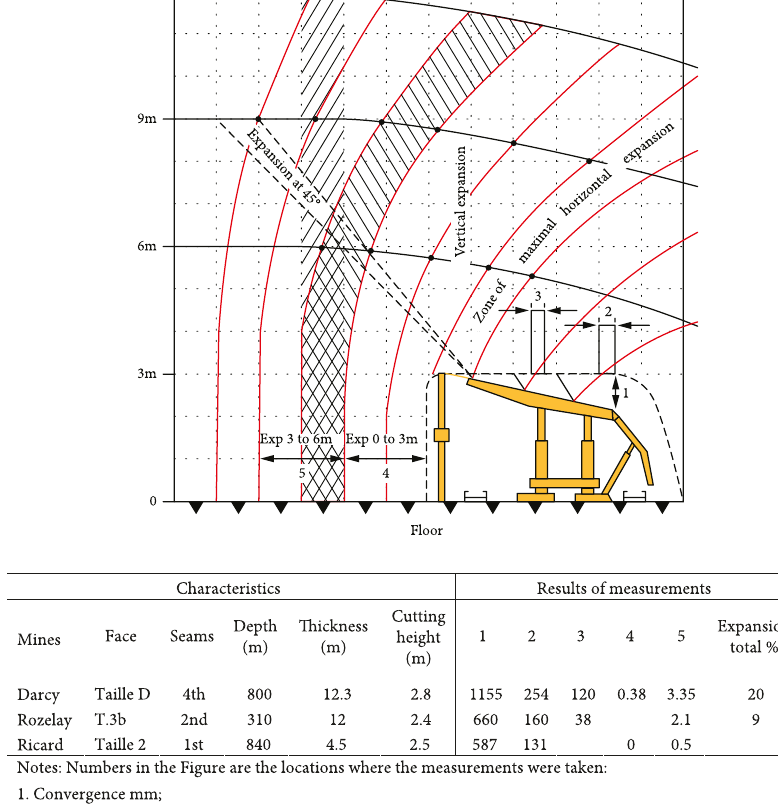
Figure 8: Field observations of top coal deformation and fl ow observed in French ’ s coal mines in the 1960s and 1970s (after [154] and copying from [24]).